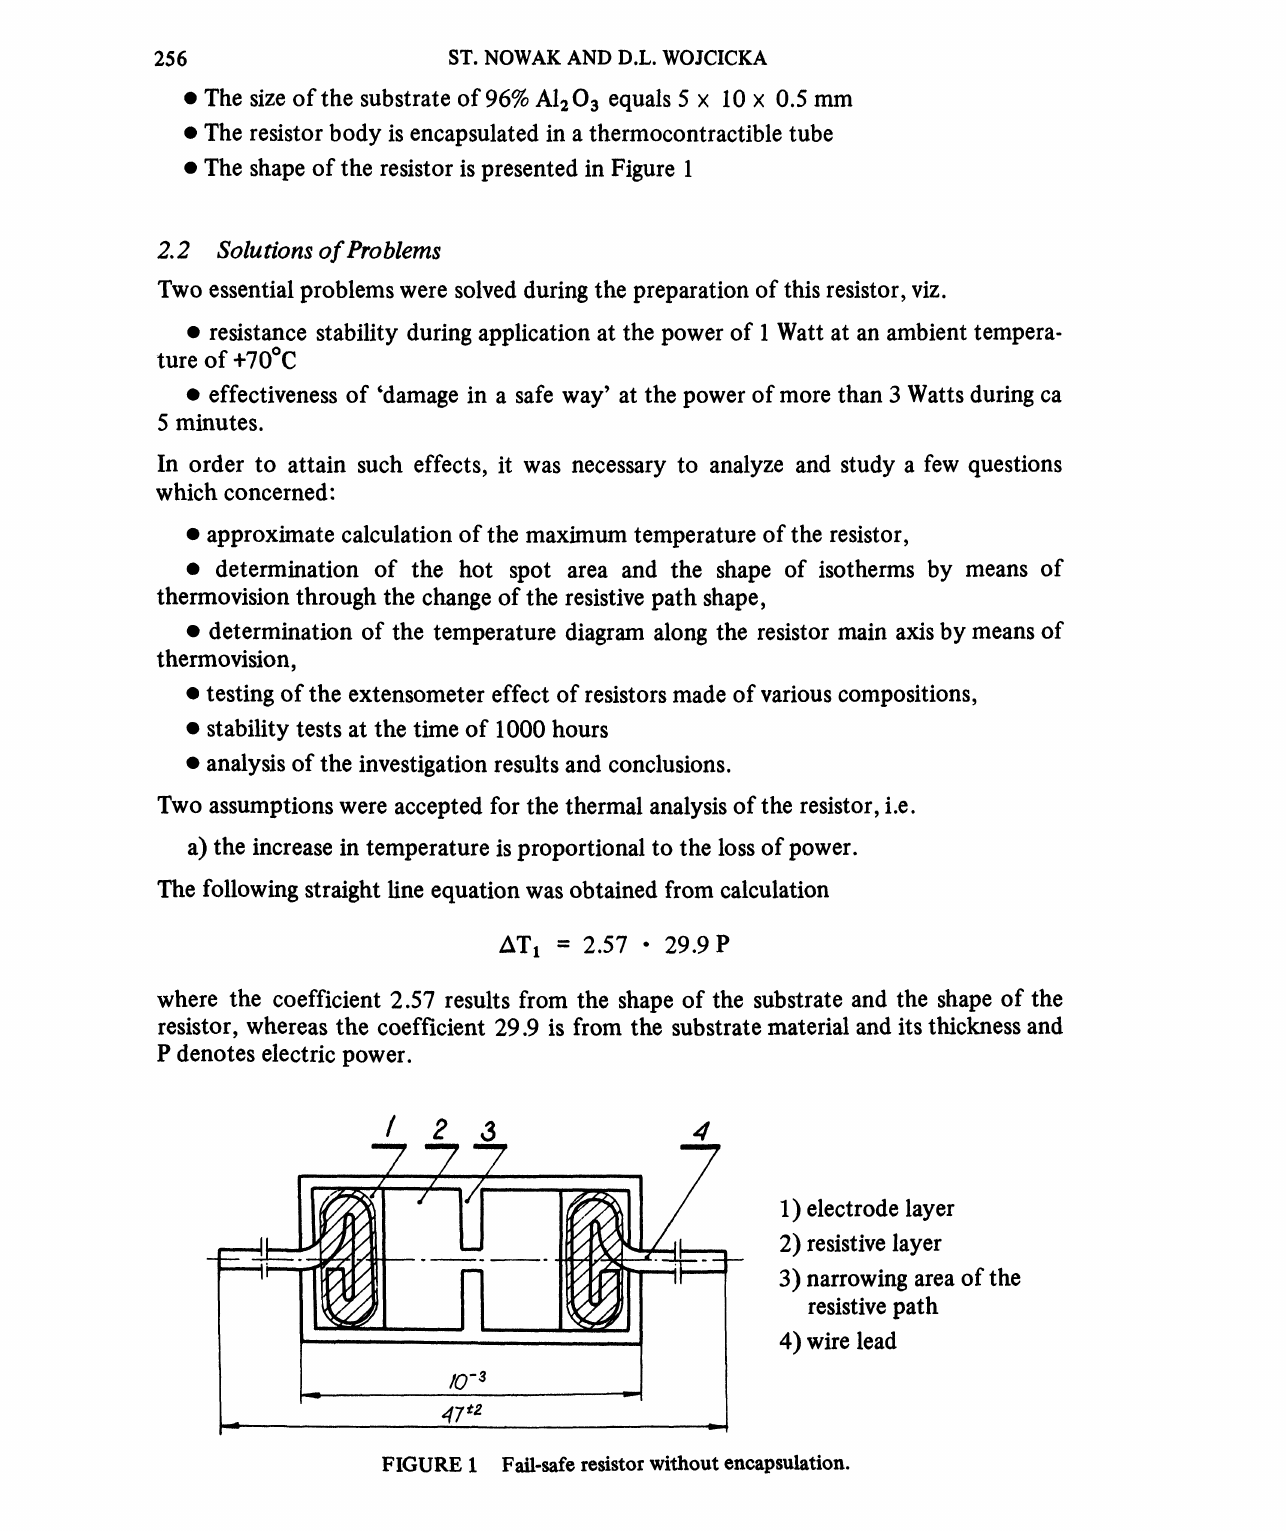
Fail-safe resistor without